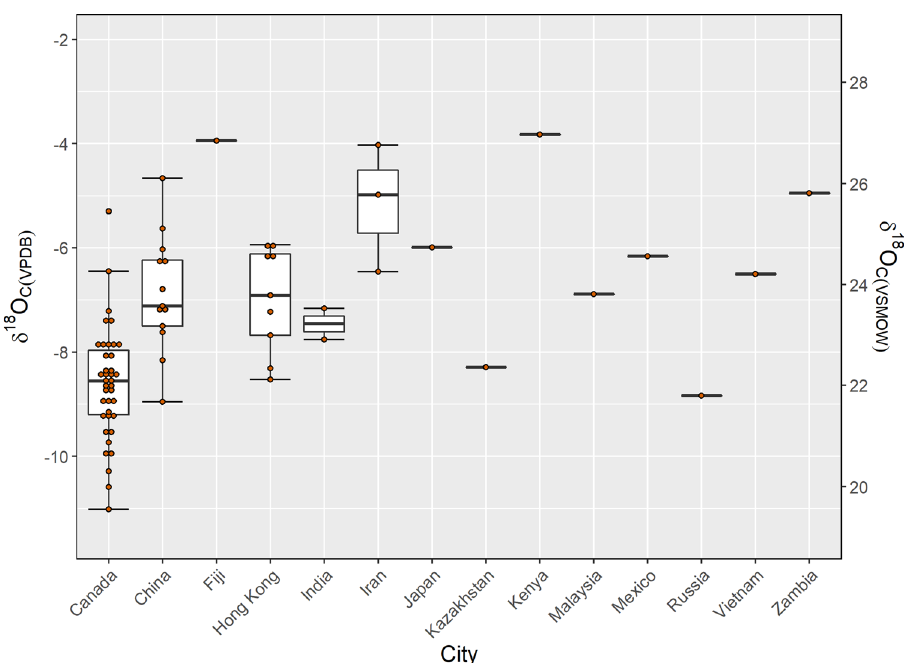
Figure 8. A boxplot of δ 18 O c values for the globally aggregated data represented by country (n = 75). The boxes represent 25th and 75th percentiles, and whiskers represent the maximum and minimum observations. When outliers are present, the whiskers extend to 1.5 times the interquartile range. The middle line denotes the median or 50 th